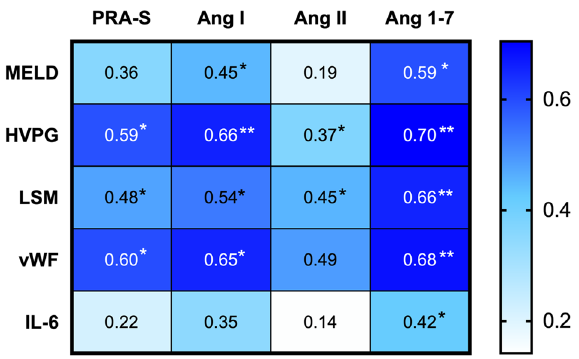
Figure 2. Correlations between components of the classical and alternative RAS (PRA-S, Ang I, Ang II and Ang 1–7) and parameters of liver disease severity (MELD), severity of portal hypertension (HVPG), liver stiffness (LSM), endothelial dysfunction (vWF) and inflammation (IL-6). Correlations were assessed using Spearman’s Rho. * denotes p values < 0.05, whereas ** indicates p values < 0.001. Ang angiotensin, HVPG hepatic venous pressure gradient, IL-6 interleukin-6, LSM liver stiffness measurement, MELD model for end-stage liver disease, RAS renin–angiotensin system, PRA-S plasma renin activity surrogate, vWF von Willebrand factor